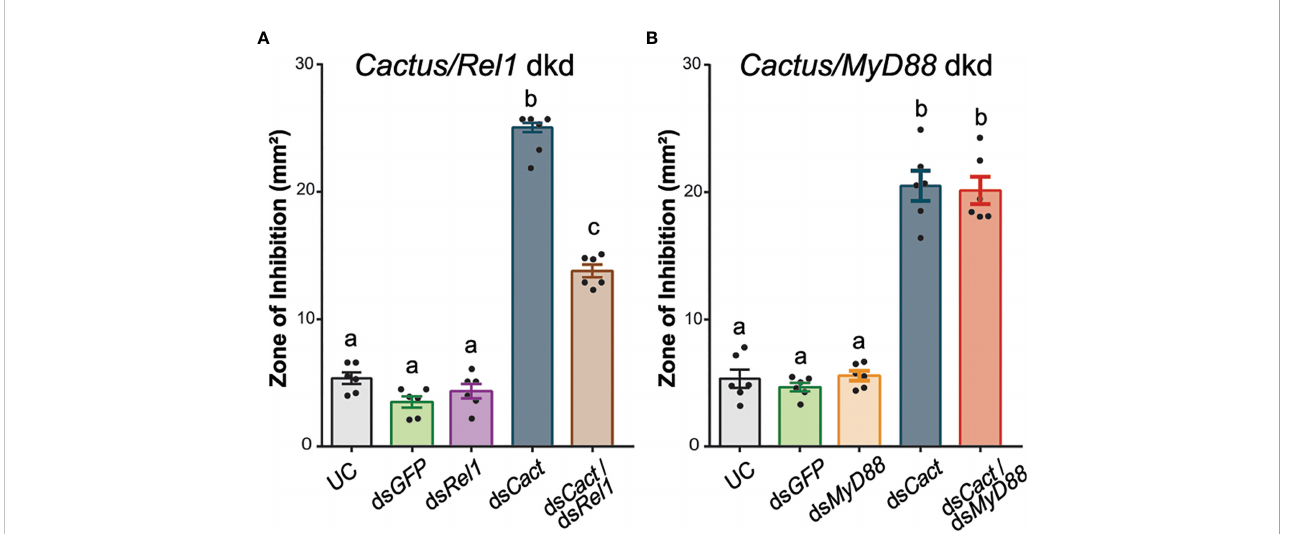
FIGURE 4 Ds REL1 injection partially reverses the antimicrobial activity induced by CACT kd. (A) Zone of inhibition (ZOI) produced by the hemolymph of mosquitoes injected with ds REL1 /ds GFP , ds CACT /ds GFP , and ds CACT /ds REL1. Uninjected and ds GFP- injected mosquitoes acted as negative controls. (B) ZOI produced by the hemolymph of mosquitoes injected with ds MyD88 /ds GFP , ds CACT /ds GFP , and ds CACT /ds MyD88. Uninjected (UC) and ds GFP- injected mosquitoes acted as negative controls. Data are shown as means ±1 standard error ( n = 6). One-way ANOVA, followed by Bonferroni ’ s multiple- comparison post-test, was performed to calculate the statistical signi fi cance ( P < 0.05). Means with the same letter are not signi fi cantly